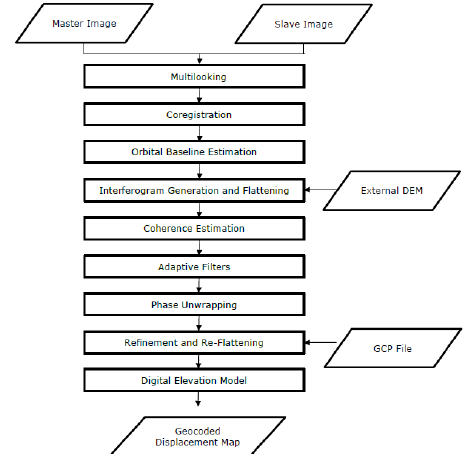
Figure 4. DInSAR based method ice sheet velocity estimation (Adopted from Sood, 2015 and Thakur et al., 2016) The ice sheet velocity was also estimated using co-registered optical image based feature tacking method (Leprince et al., 2007).